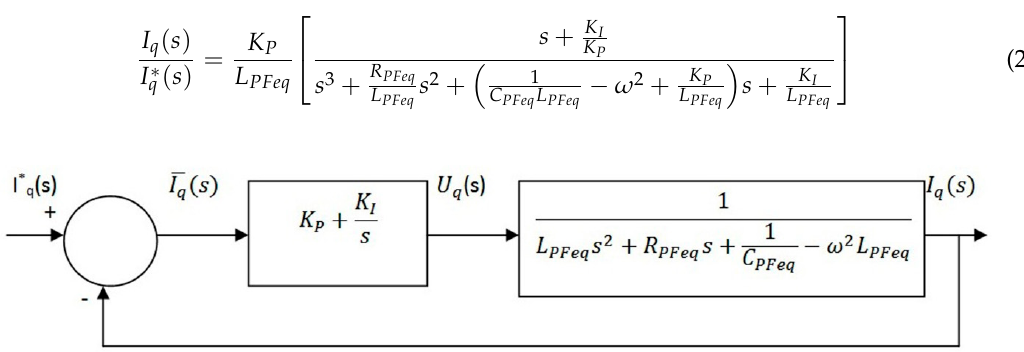
Figure 2. Structure of current control loop for i q and i d.